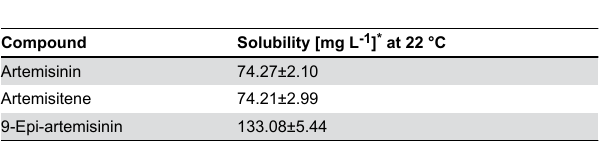
Table 3. Solubility of artemisinin, artemisitene and 9-epi- artemisinin in water at 22 °C and atmospheric